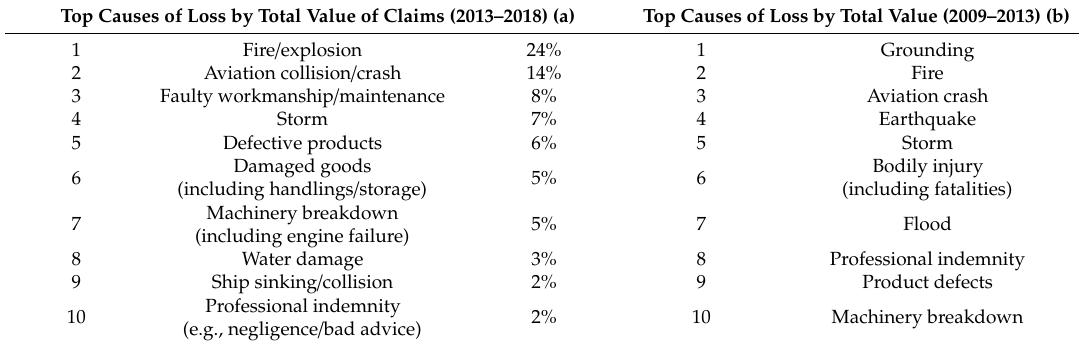
Table 1. The top causes for business losses in 2018 (a) and 2014